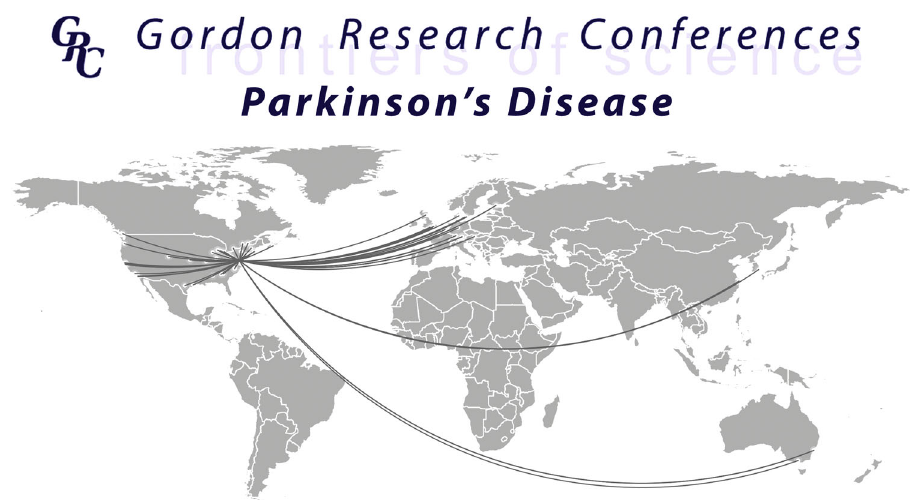
Fig. 1 The Gordon Research Seminar & Conference on Parkinson ’ s disease was attended by 200 scientists from 15 nations representing four continents. There were almost 50 invited speakers, and more than 100 posters were presented. Three Carl Storm Underrepresented Minority Fellowships were awarded by the